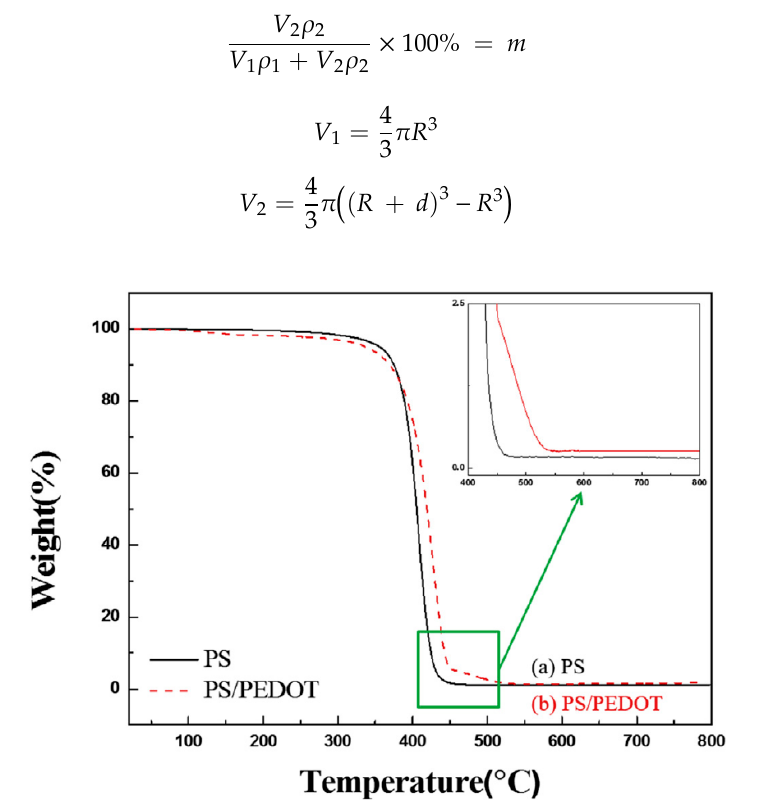
/ PEDOT (An et al. [87], © Elsevier,